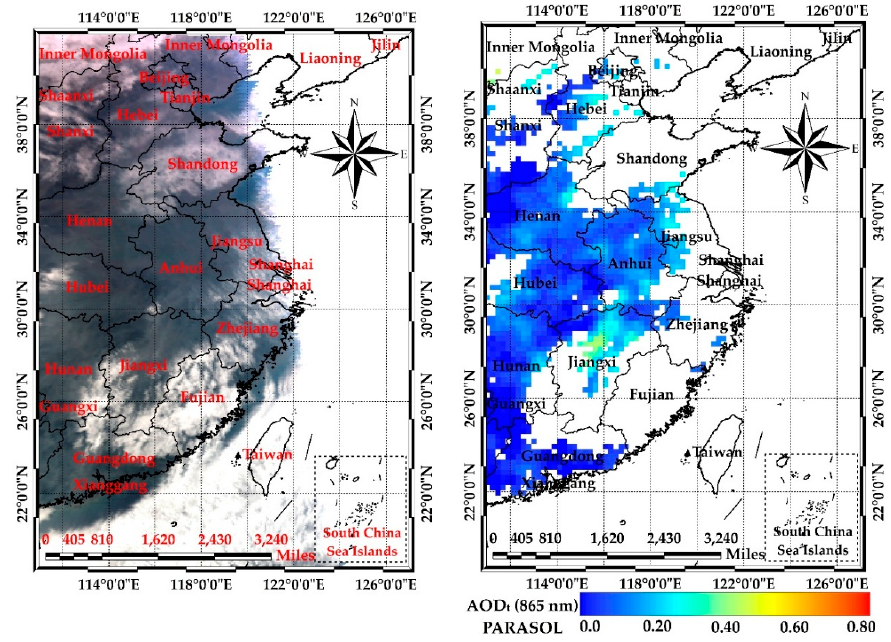
Figure 3. As in Figure 2, but for 23 December 2012.